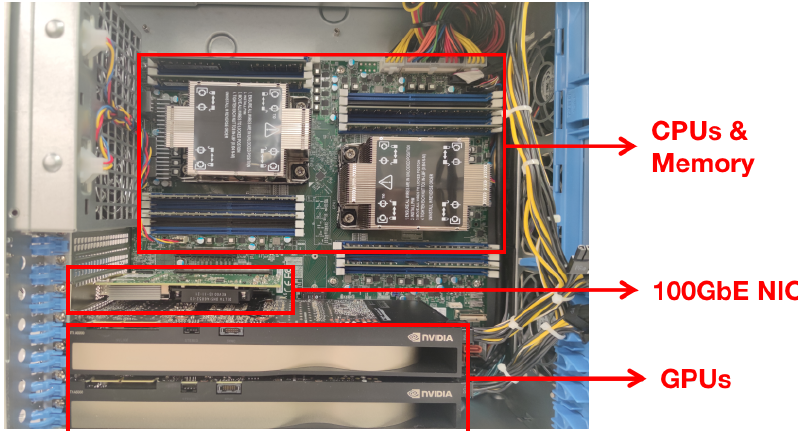
Figure 3. Key hardware inside the GPU